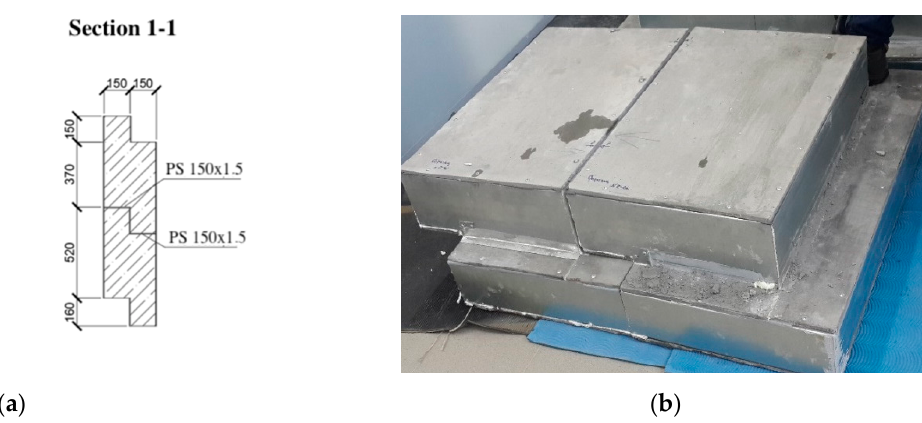
Figure 2. Second specimen for testing. ( a ) Specimen dimensions; ( b ) specimen photo. The third test specimen (see Figure 3) consisted of two panels. Dimensions of the first panel were 1000 (L) × 1200 (H) × 310 (W), and those of the second panel were 1000 (L) × 600 (H) × 310 (W), where L, H, and W are the width, height, and thickness of the structure (in millimeters), respectively. The specimen had a vertical field joint. At the junction of the panels, two layers of heat-insulating material Izolon were used. The composition of sample No. 3 was identical to that of sample No. 2 , except for the dimensions of the left half-panel.